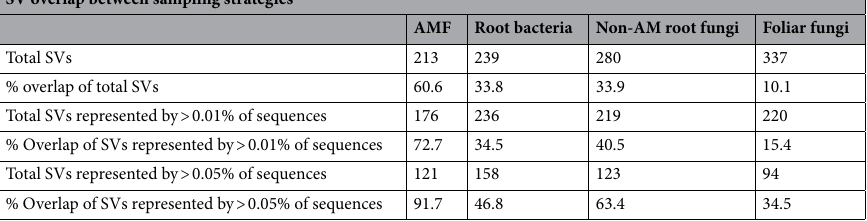
Table 1. Total number and overlap of SVs when gradually filtering low abundant SVs of microbial communities recovered from milkweed leaves and roots using two different subsampling strategies (subsampling before homogenization and subsampling after homogenization of tissue).